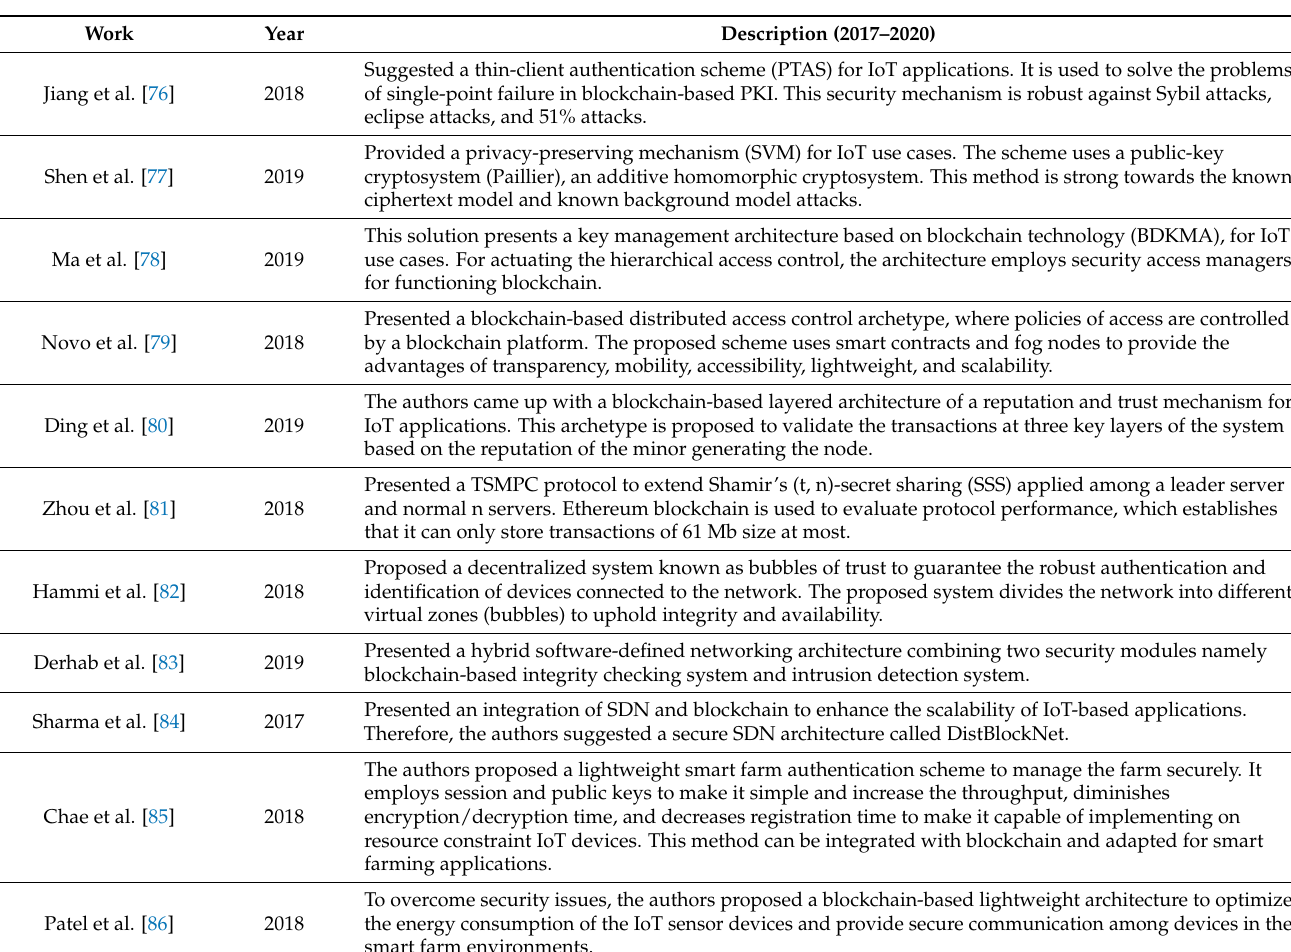
Table 3. Blockchain-based solutions for the cyber security threats of IoT-based Agrifood Supply Chain